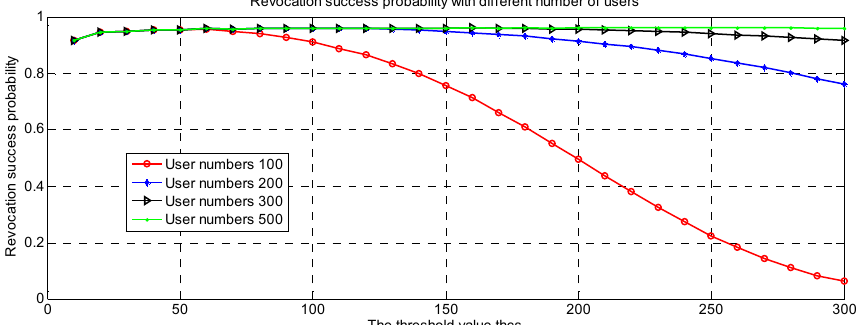
Figure 5. Revocation success probability with different numbers of users.